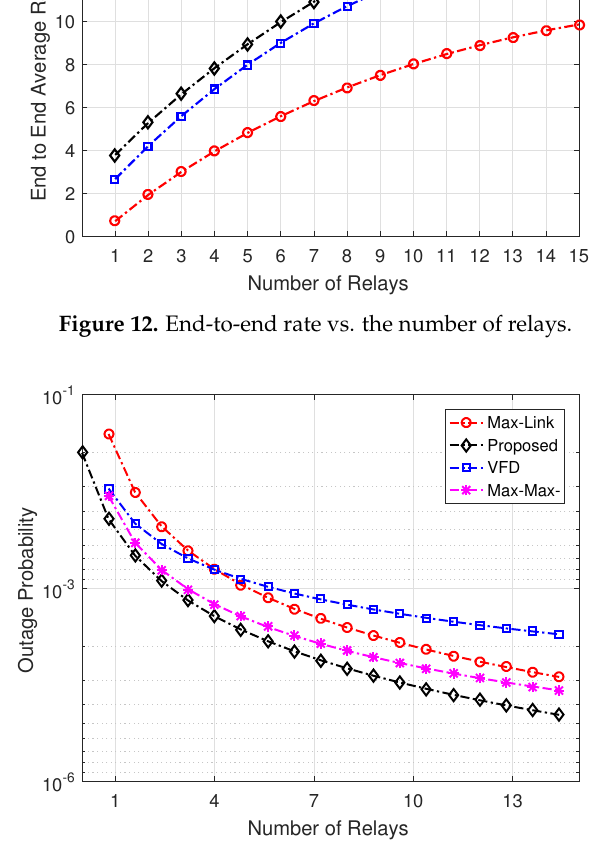
Figure 13. Outage probability vs. the number of relays.